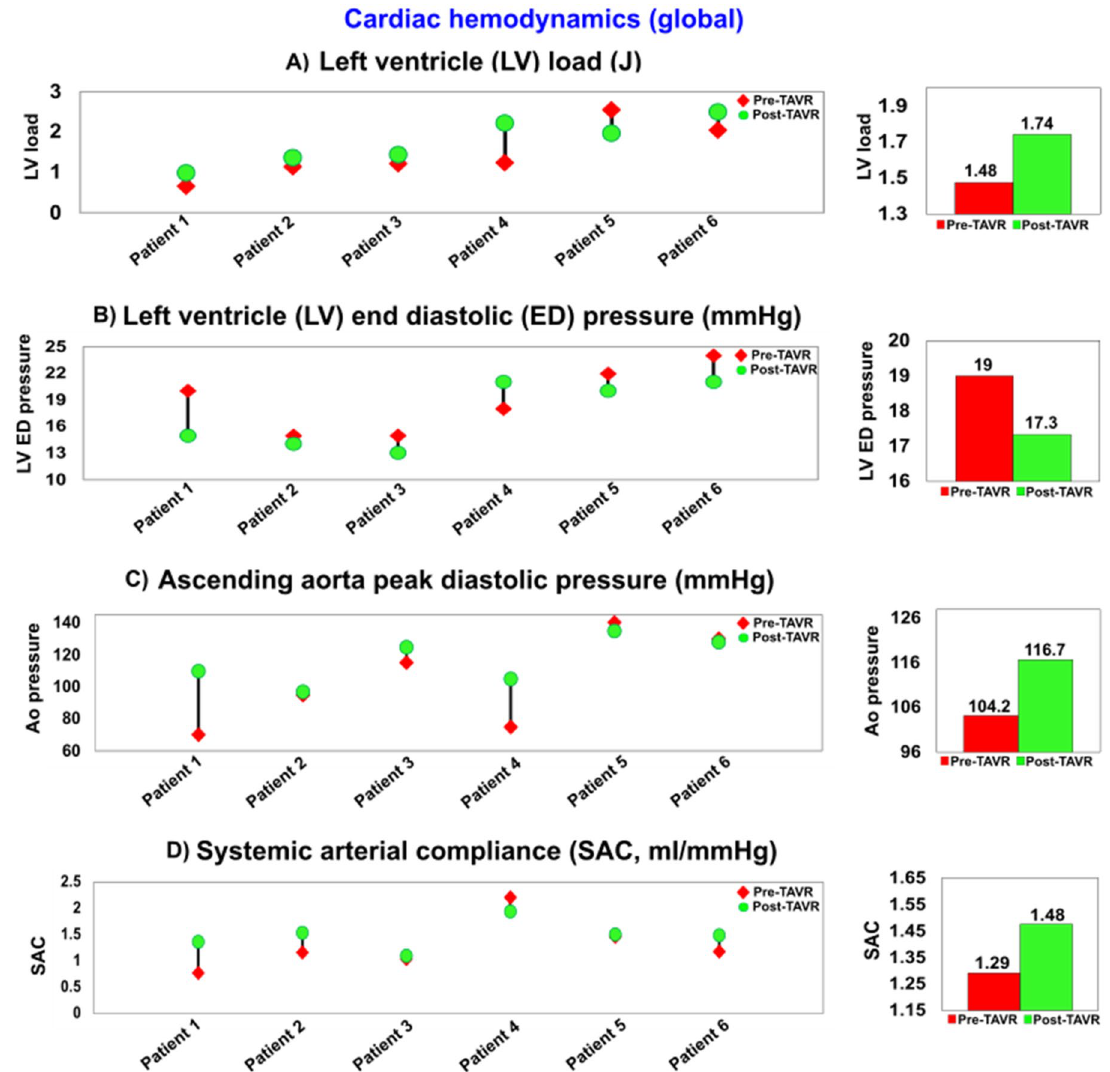
Figure 16. Changes in global hemodynamics (metrics of cardiac function & metrics of circulatory function) in patients between baseline and 90-day post TAVR (N = 6). ( a ) Left ventricle workload; ( b ) Left ventricle end diastolic pressure; ( c ) Ascending aorta peak pressure in diastole; ( d ) Systemic arterial